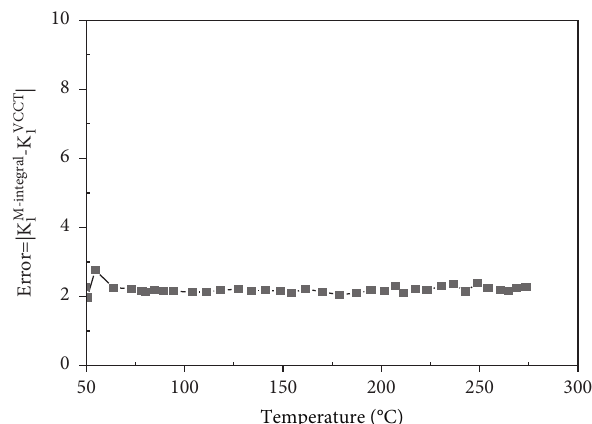
Figure 20: Error margin between the results of M-integral and VCCT K I .